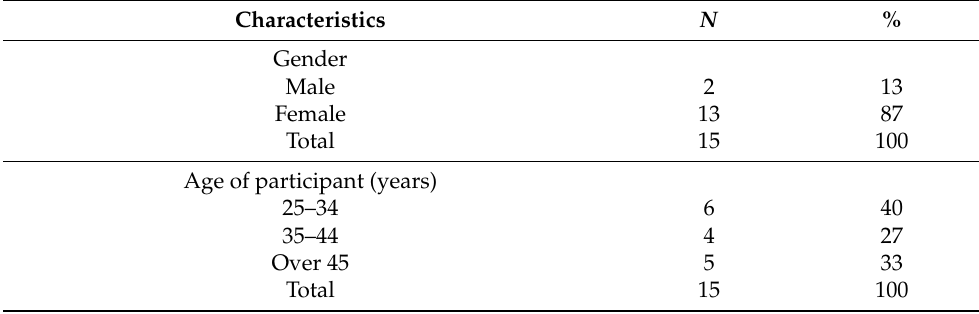
Table 1. Characteristics of